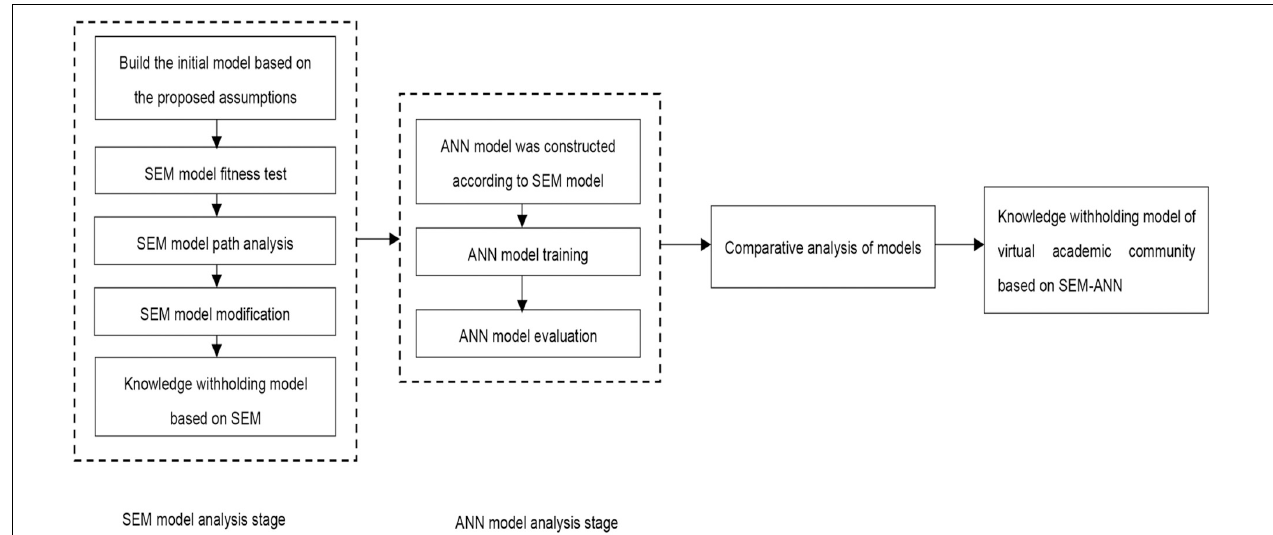
FIGURE 2 | Structural equation method-artificial neural network (SEM-ANN) model flow